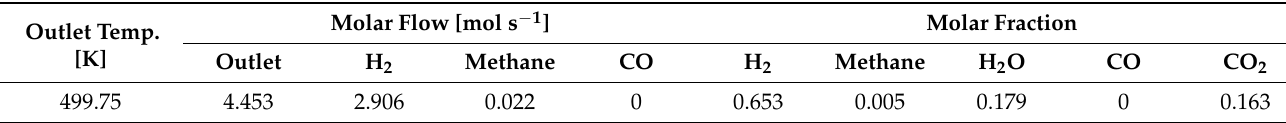
Table 7. Results for (WGS + PROX reactor) outlet side.